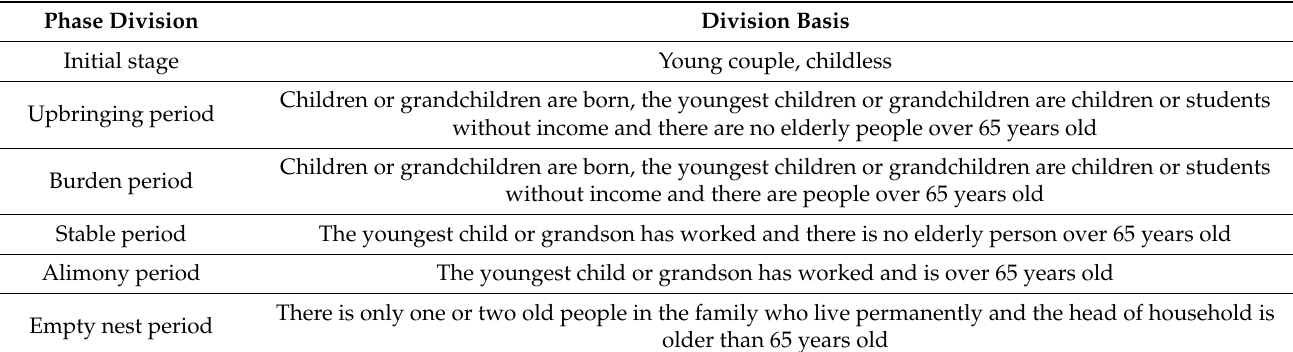
Table 1. Division of family life cycle